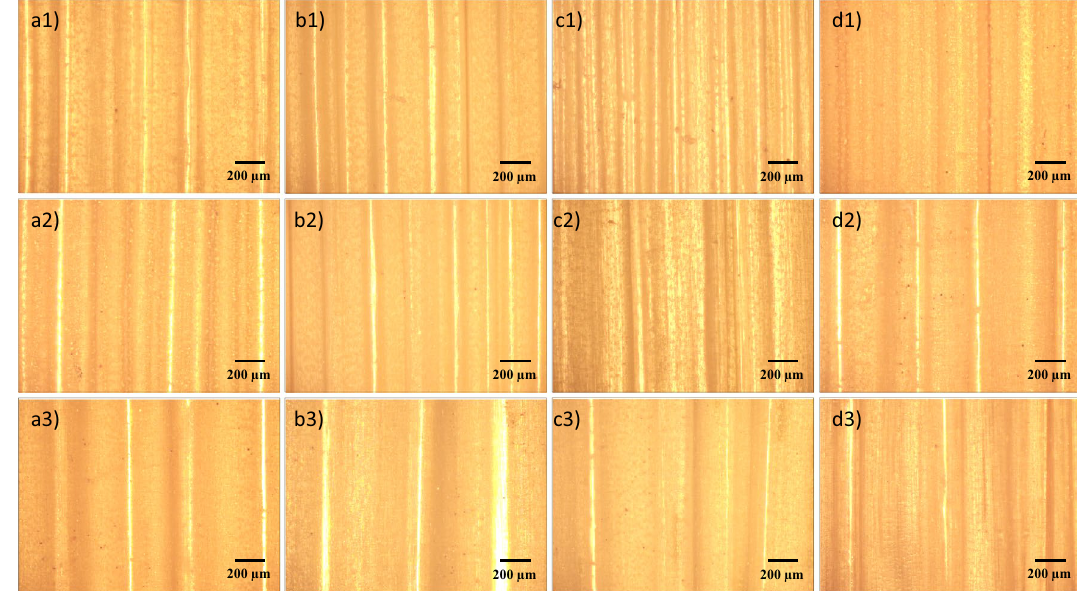
Figure 2. The surface morphologies of culm wall of ( a ) R1, ( b ) R2, ( c ) R3, and ( d ) R4. The numbers 1, 2, and 3 in figure indicate that the morphologies were taken from the top, middle and bottom of the stem wall, respectively.